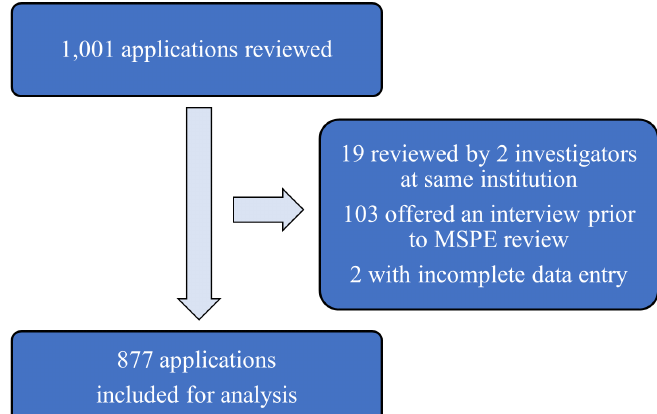
Figure 1. Flow of application review and analysis. MSPE, Medical Student Performance